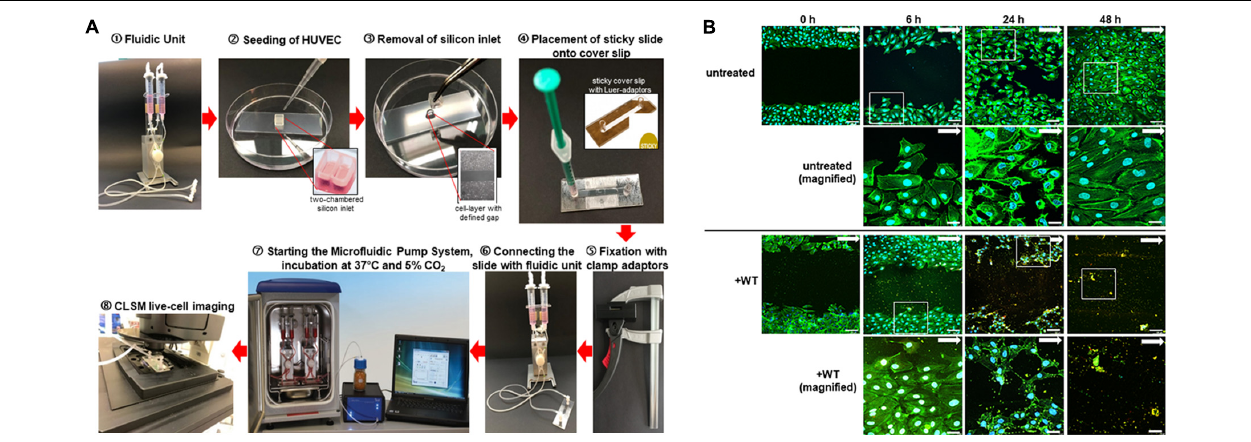
FIGURE 5 | Workflow and fluorescence images of chamber separation migration analyses under defined shear stress conditions. (A) Workflow. Two pump reservoirs of a fluidic unit are filled with cell culture medium for cell cultivation in flow (cid:192) . For cell migration analysis, the cells are seeded into the two chambers of a gelatin-coated silicone inlet placed on a microscope slide (cid:193) . After cell cultivation, the silicone inlet is removed leaving a defined spatial distance of 500 µ m between the two cell layers (cid:194) . The microscope slide is covered with a “sticky coverslip” leaving a groove for perfusion with cell culture medium (cid:195) . After the sticky coverslip is fixed with clamping tongs to ensure tight coverage over the whole time of flow cultivation (cid:196) , the connection of the slide with the perfusion was set (cid:197) . According to the chosen fluidic parameters, the defined continuous and unidirectional microfluidic perfusion is started (cid:198) . Cell migration is microscopically visualized using the CLSM Sp8 at different time points (cid:199) . (B) Representative microscopic fluorescence images of HUVEC gap closure at time points 0, 6, 24, and 48 h of microfluidic cultivation at 10 dyn/cm 2 . After indicated incubation times, CSMA samples without bacteria (untreated) and with pneumococci (+WT) were stained using green fluorescent phalloidin Alexa-488 in combination with DAPI for detection of cellular nuclei in blue. In case of bacterial incubation, differential immuno fluorescence staining visualizes attached bacteria in yellow. White arrows mark the direction of flow, and white squares encircle the region of magnification taken at 630-fold magnification each shown in the image below. Images were generated using the CLSM (Leica Sp8) at 200-fold magnification. Scale bar represents 100 and 10 µ m, respectively, in the